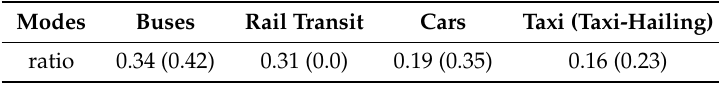
Table 4. Proportion of journeys made using each mode of transport.